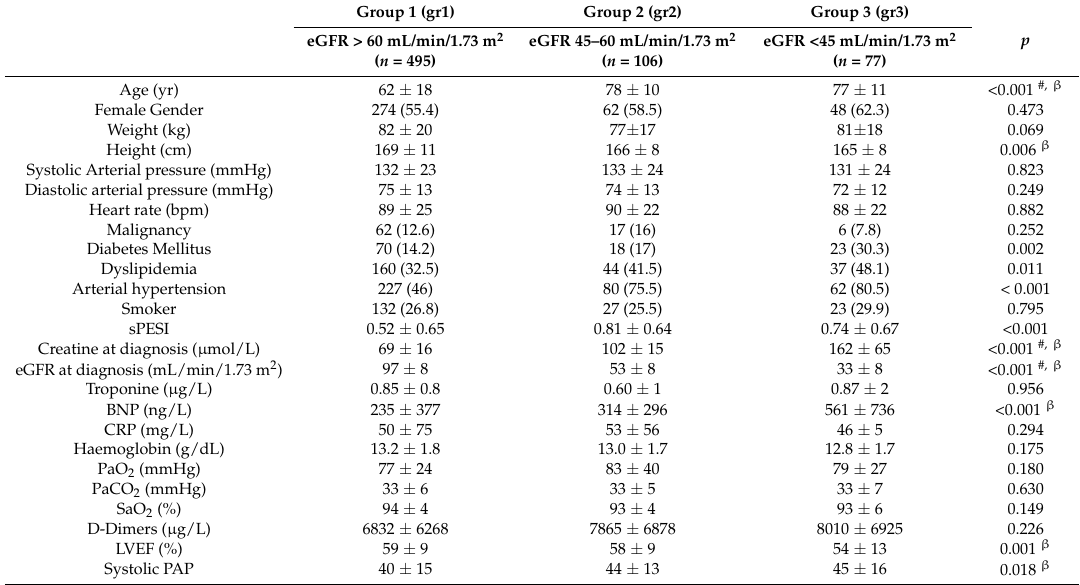
Table 1. Baseline clinical and echocardiographic characteristics.